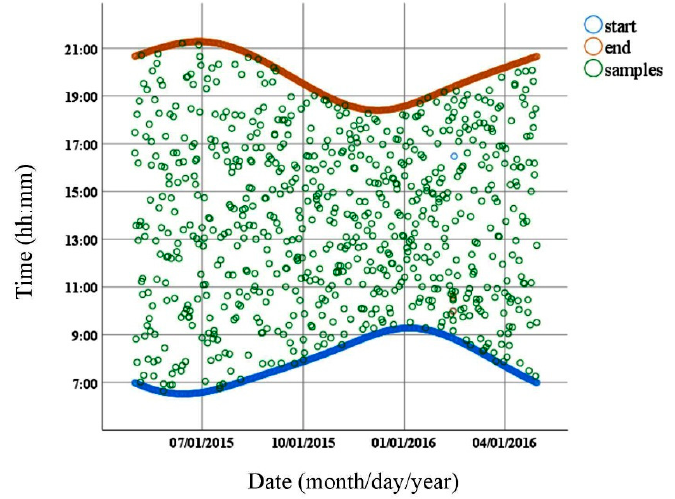
Figure 1. Time distribution of selected images.